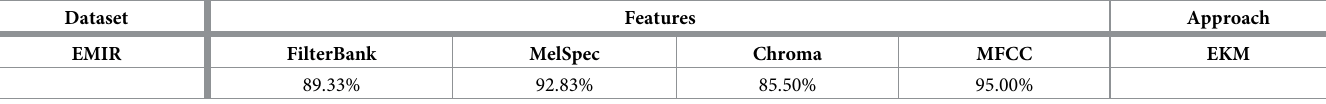
Table 2. Experiment 1: Recognition accuracies of VGG networks on EMIR using FilterBank, MelSpec, MFCC and Chroma features with 3s samples. Dataset